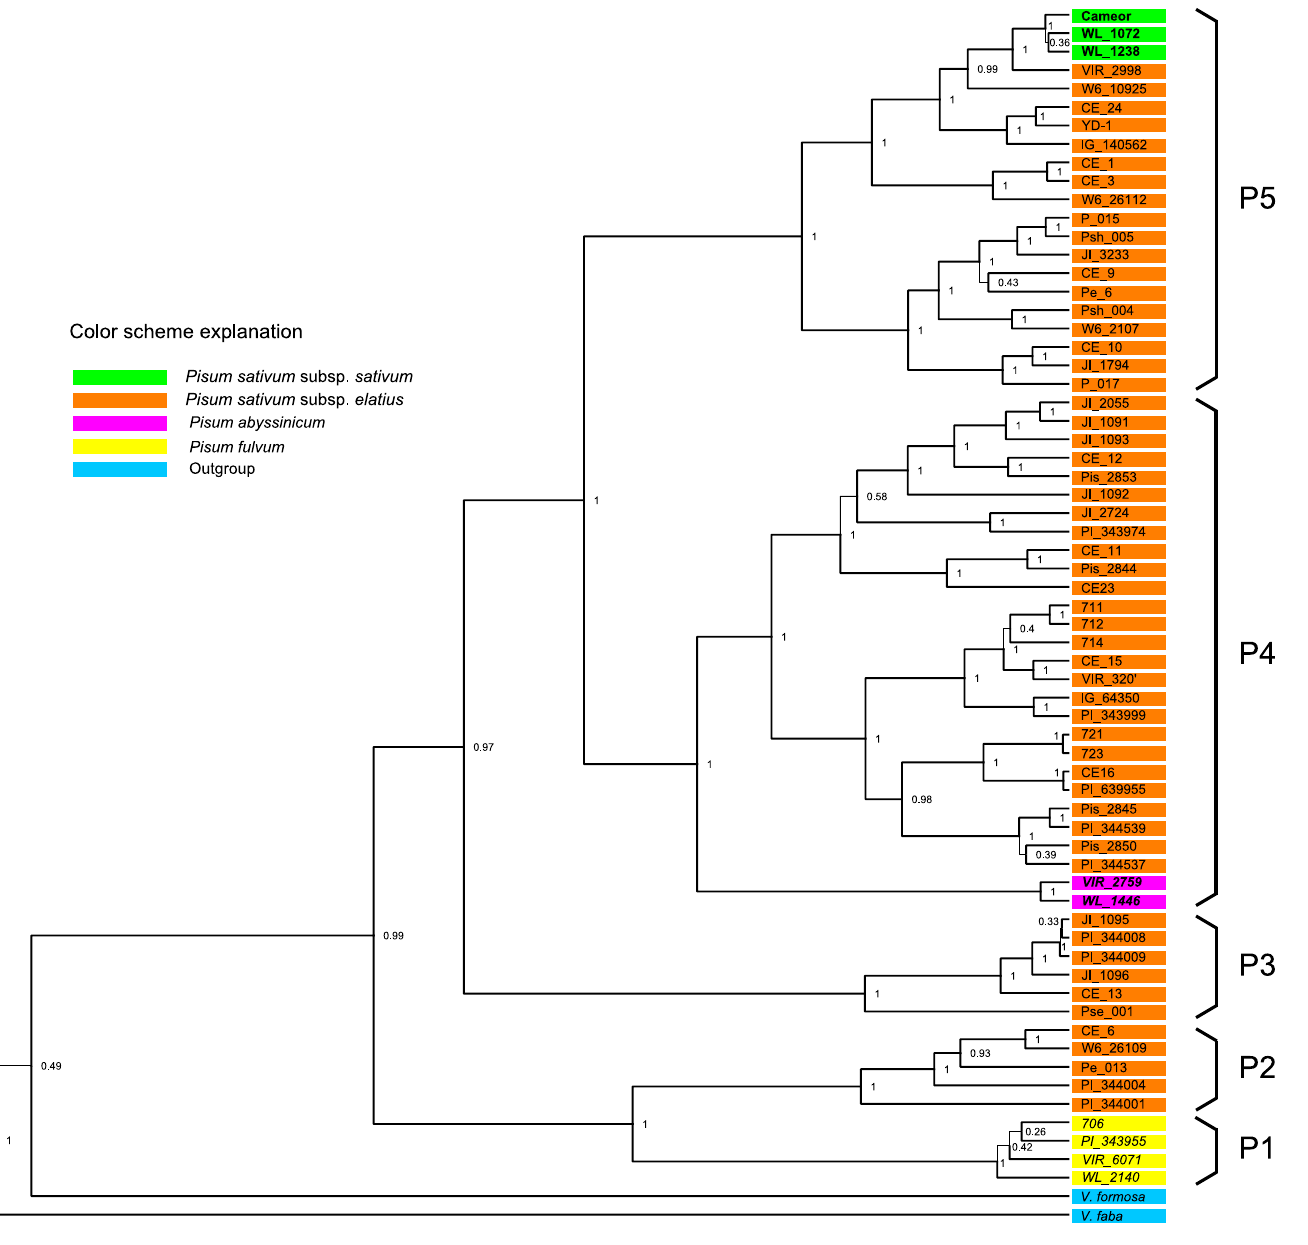
Figure 1. Reconstruction of the pea phylogeny of on the basis of the plastid genomes obtained with Bayesian MCMC method. Posterior probabilities of the nodes are indicated. Scale bar corresponds to the expected number of nucleotide substitutions per site. Main phylogenetic branches are denoted with P1-P5. Accessions of Pisum fulvum are italicised, P. abyssinicum are bold italicised, P. sativum subsp. elatius s.l. are regular Roman and the cultivated subspecies P. sativum subsp. sativum are boldfaced. Vicia faba and Vavilovia formosa comprise the outgroup.